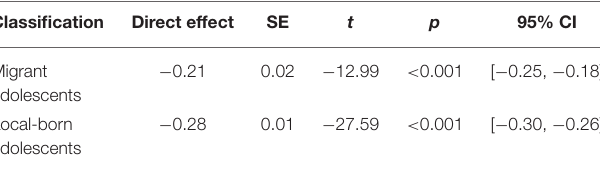
TABLE 5 | Conditional direct effect of family functioning on internalizing problems for two migrant statuses.